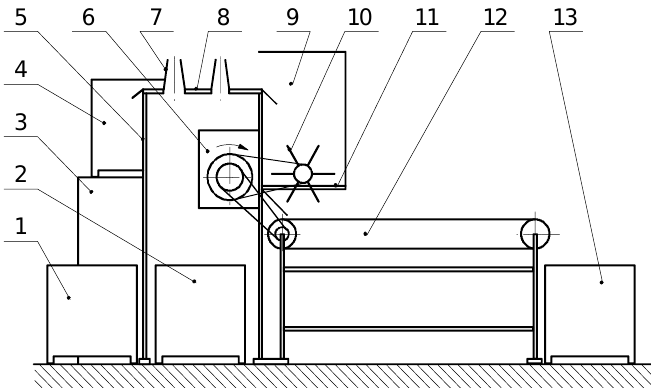
Figure 1. Schematic diagram of the designed vegetable crusher for cauliflower and broccoli inflorescences: 1 — waste container (e.g., for discarded leaves), 2 — container for separated stalks, 3 — platform, 4 — container for unprocessed vegetables, 5 — load-bearing frame, 6 — electric motor, 7 — floretting knife, 8 — processing table, 9 — crushing chamber, 10 — cutters of the crushing roller, 11 — screen at the bottom of the hopper, 12 — conveyor belt, 13 — container for separated florets.